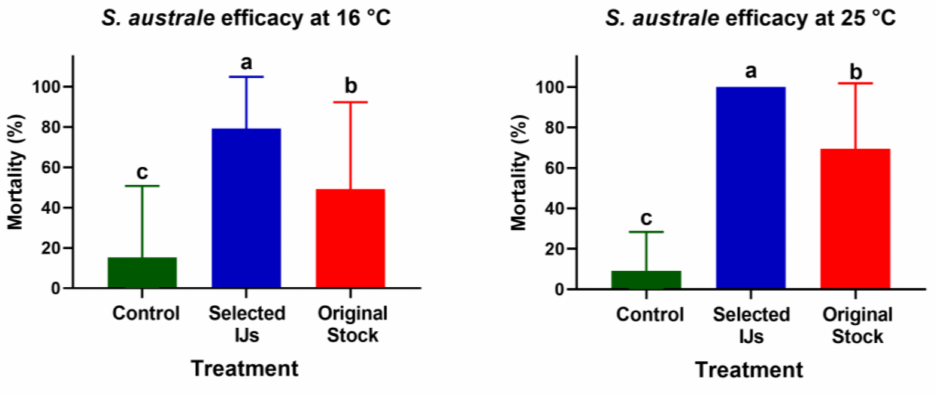
Figure 5. Efficacy (mean ± SEM) of selected S. australe against A. nodipennis larvae in 35 L pots under two different soil temperatures. Mortality was recorded 72 h after nematode application. Different letters represent differences according to the Tukey HSD test ( p ≤